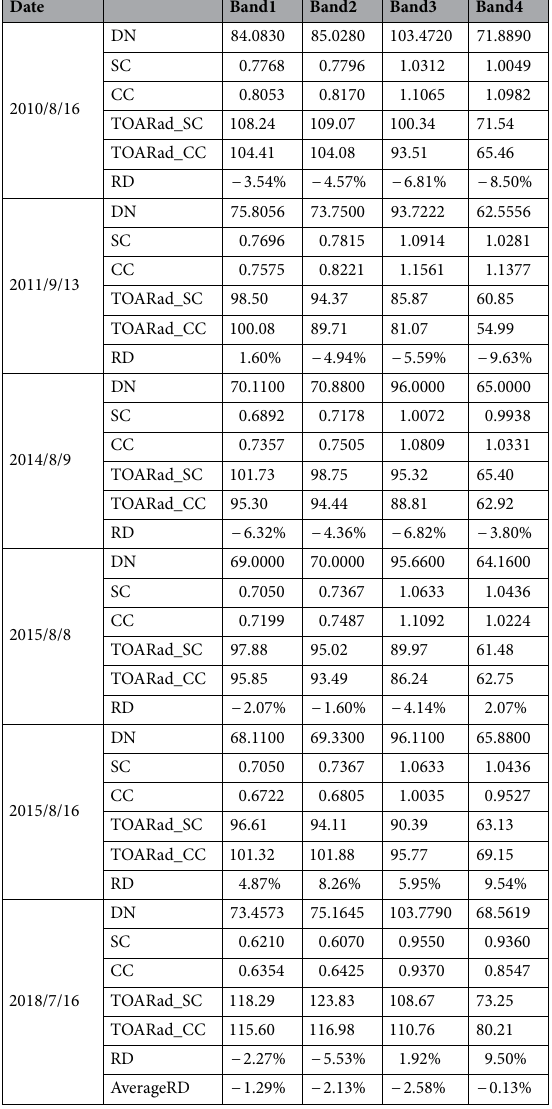
Table 2. Comparison of at-sensor radiance determined from the site calibration and cross calibration. Rad Unit: W/(m 2 sr